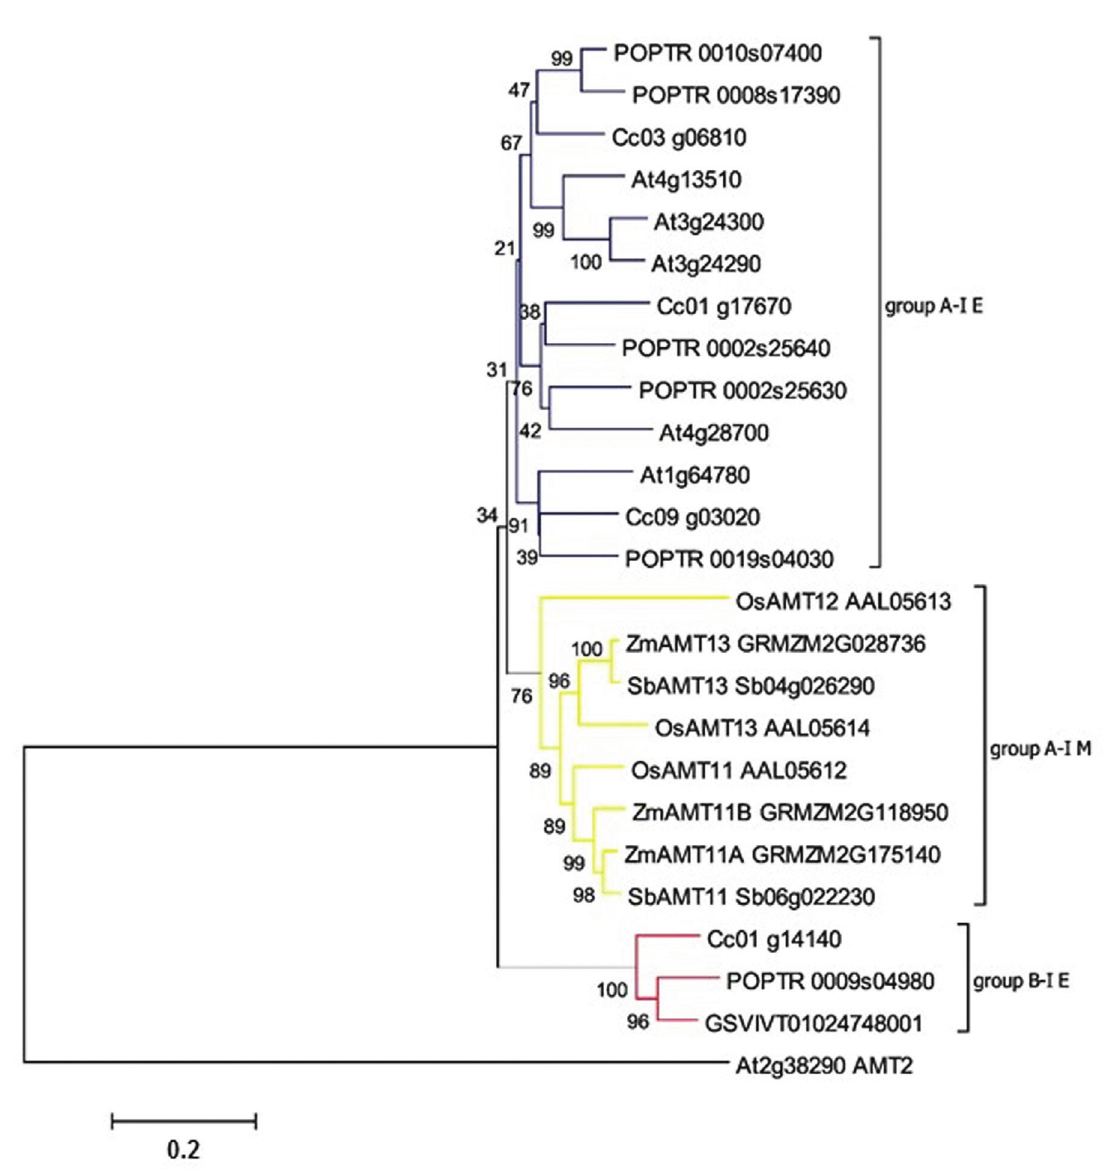
Figure1 -Neighborjoiningphylogeneticanalysisofthe AMT1 family.Thetreewasrootedusingan A.thalianaAMT2 geneasanoutgroup.Percentboot- strap values from 1,000 replicates are given. All C. canephora genes are placed in clades with > 50% of bootstrap support. Taxonomic groups are colored based on groups: blue refers to group A eudicot sequences; yellow represents monocot sequences in group A, and red illustrates dicot sequences in group B. Accession numbers are shown. Codes were retrieved from the Coffee Genome Hub for C. canephora and Phytozome for all other species. Phylogen- etic groups were based in von Wittgenstein et al.